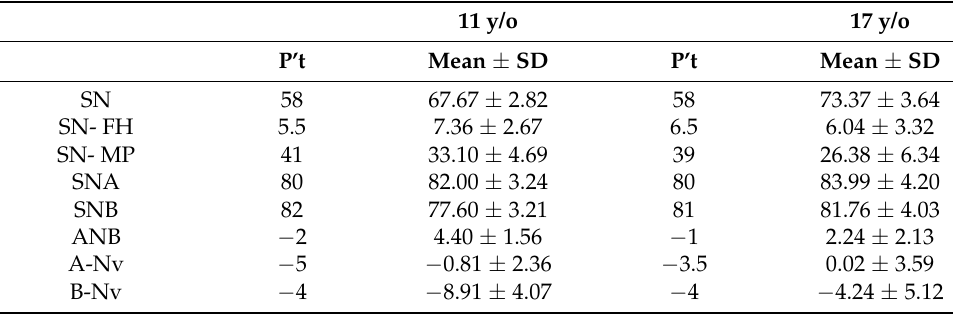
Figure 4. Superimposition of cephalometric tracings taken at the ages of 11 and 17 years. Table 1. Cephalometric tracing